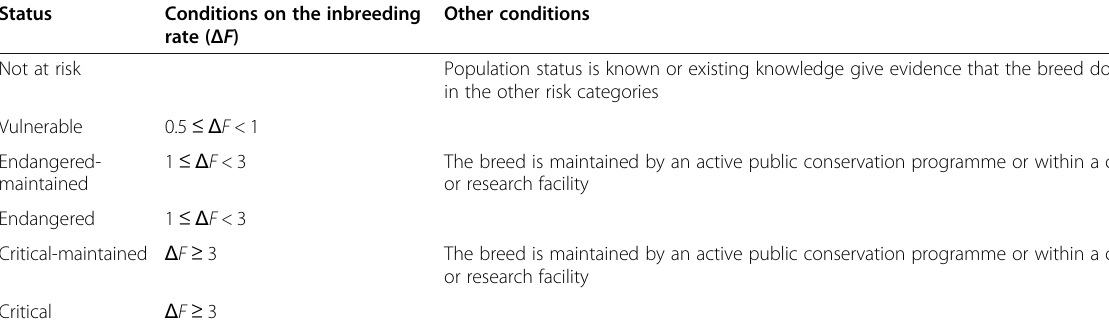
Table 1 FAO system to assess risk status of livestock breeds (FAO 2013) Status Conditions on the inbreeding Other conditions rate ( Δ F )